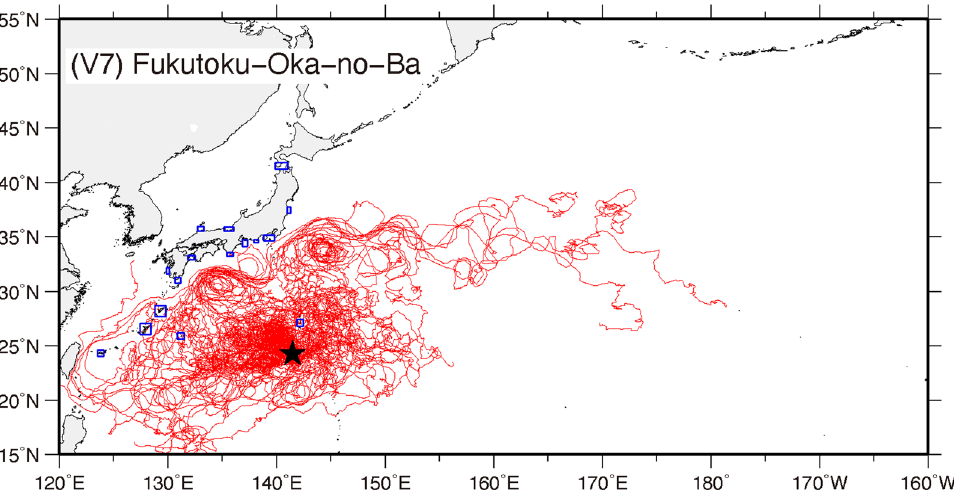
Fig. 14 Simulated drift paths of 50 randomly selected virtual pumice clasts released from (V7) Fukutoku-Oka-no-Ba submarine volcano (black star) on 15 March 2004. Blue rectangles indicate target